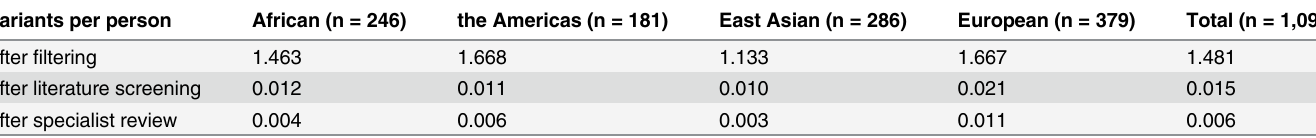
Table 2. Distribution of variants per person after filtering, literature screening, and specialist review. Variants per